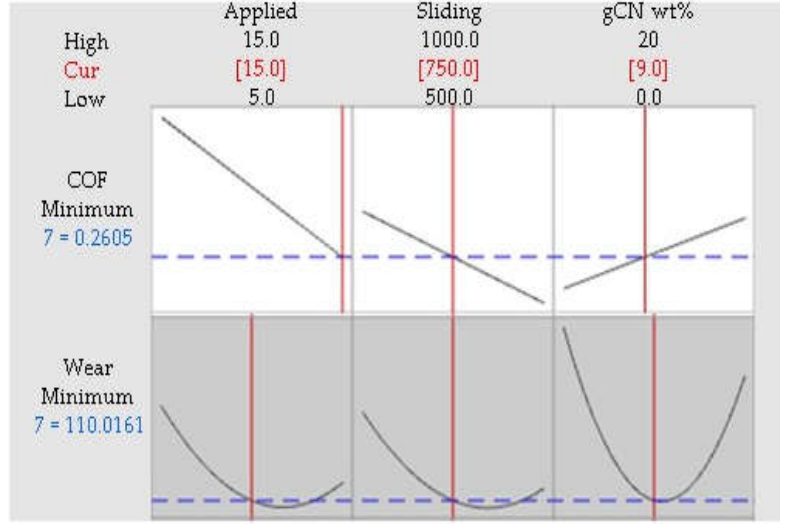
Figure 8. Plot for optimization for wear COF and wear.